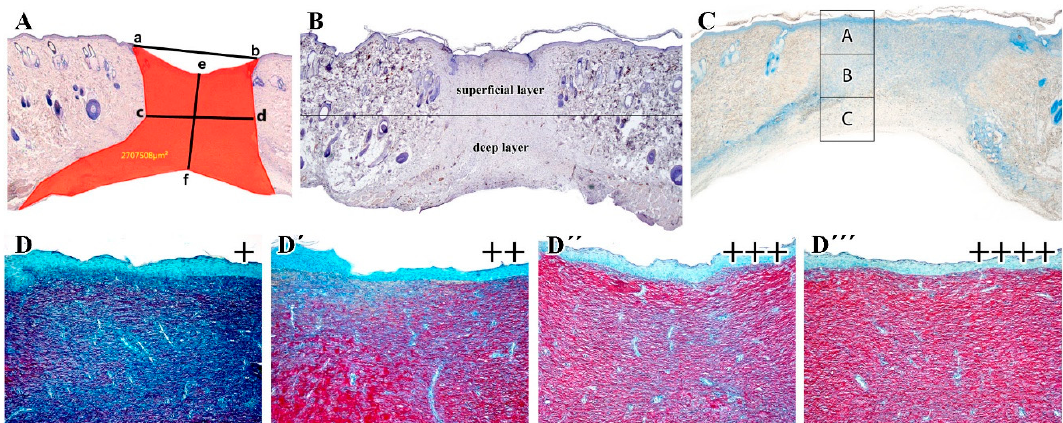
Figure 14. Overview of methodological approaches used for quantification of healing parameters. ( A ):